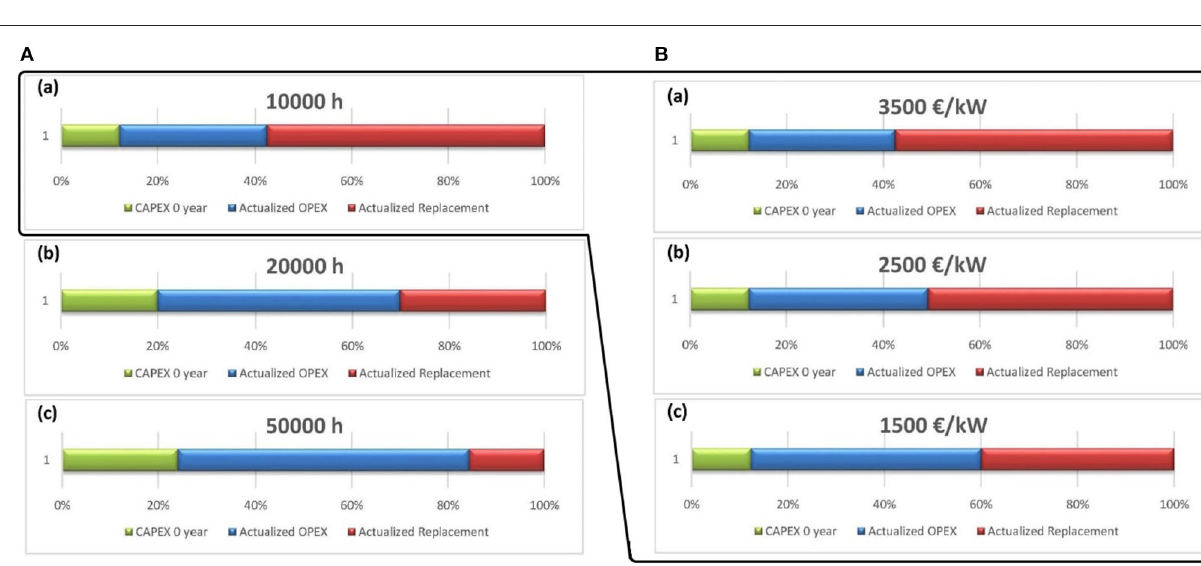
FIGURE 9 | Methane cost breakdown based on CAPEX, OPEX, and replacement of the equipment.